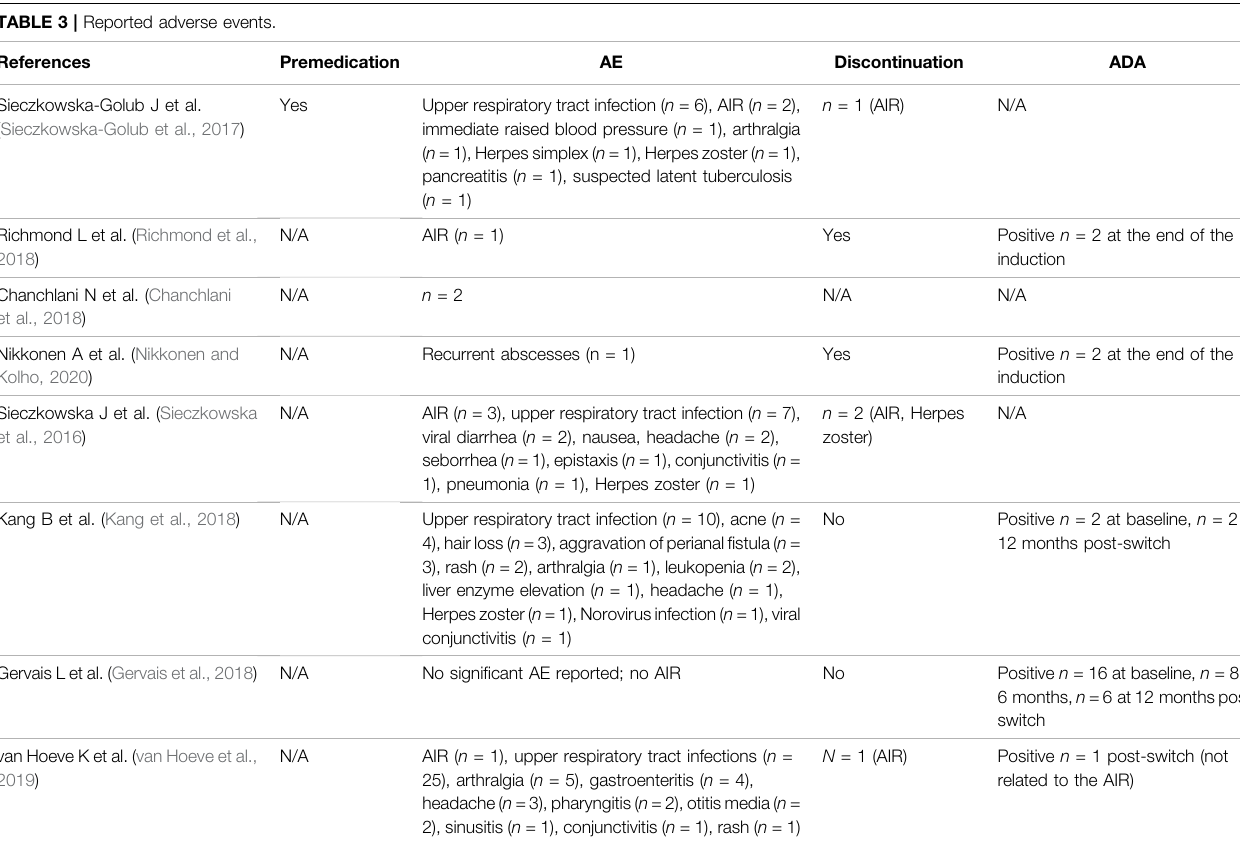
TABLE 3 | Reported adverse